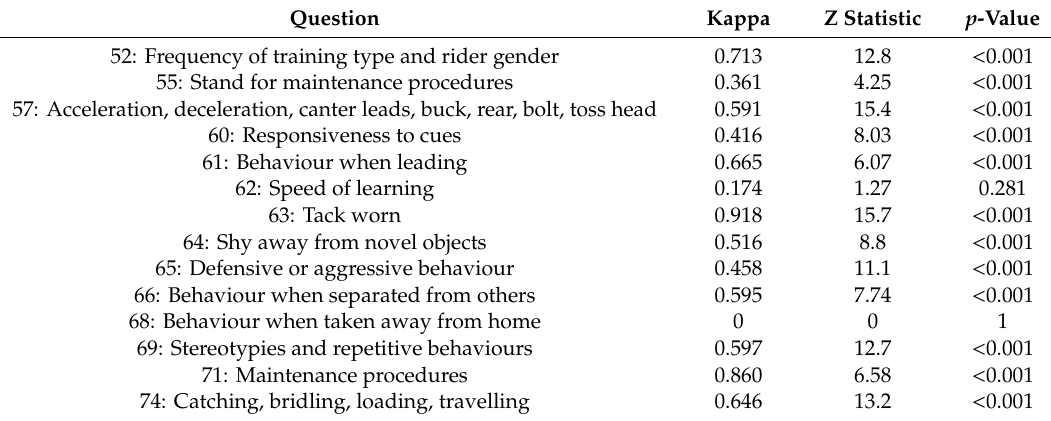
Table 5. Inter-rater reliability results. Each Equine Behavior Assessment and Research Questionnaire (E-BARQ) question listed is a matrix containing multiple individual items. Supplementary File S2 shows question numbers and question text for each matrix. The table shows Kappa scores using linear weighted Kappa